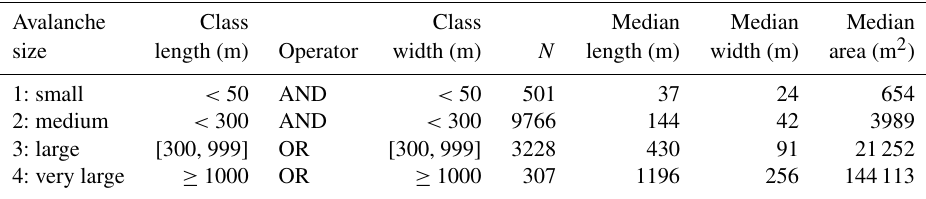
Table 1. Definition of avalanche size based on length and width of avalanche. Resulting median length, width and area per size class ( N =